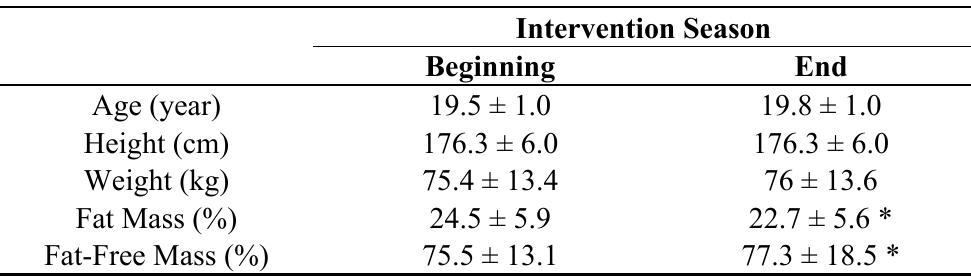
Table 1. Subject